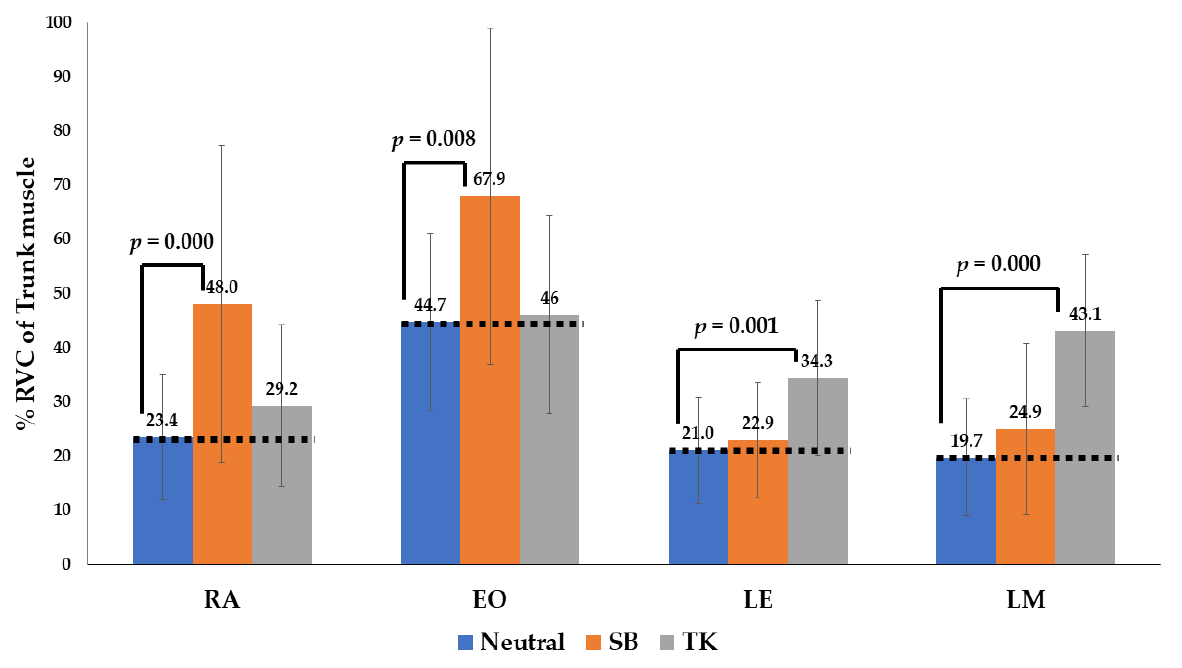
Figure 5. The percentage reference voluntary contraction (%RVC) of four trunk muscles during the swing phase of the gait. With the sway-back posture (orange), the RA and EO have a higher level of activity in the stance and swing phases compared with that of the neutral gait (blue). With the thoracic kyphosis posture (gray), the LE and LM have a higher level of activity than that of the neutral gait (blue). Abbreviations: SW, sway back; TK, thoracic kyphosis.